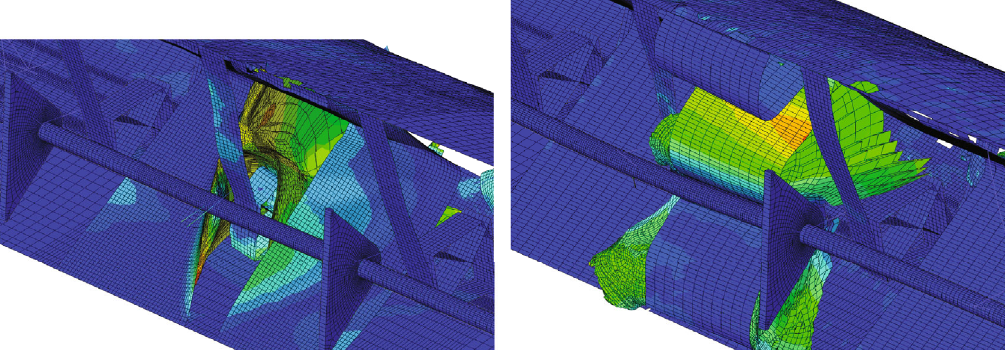
Figure 27: Bird strike test: impact on a compliant rib (left) and impact between two compliant ribs